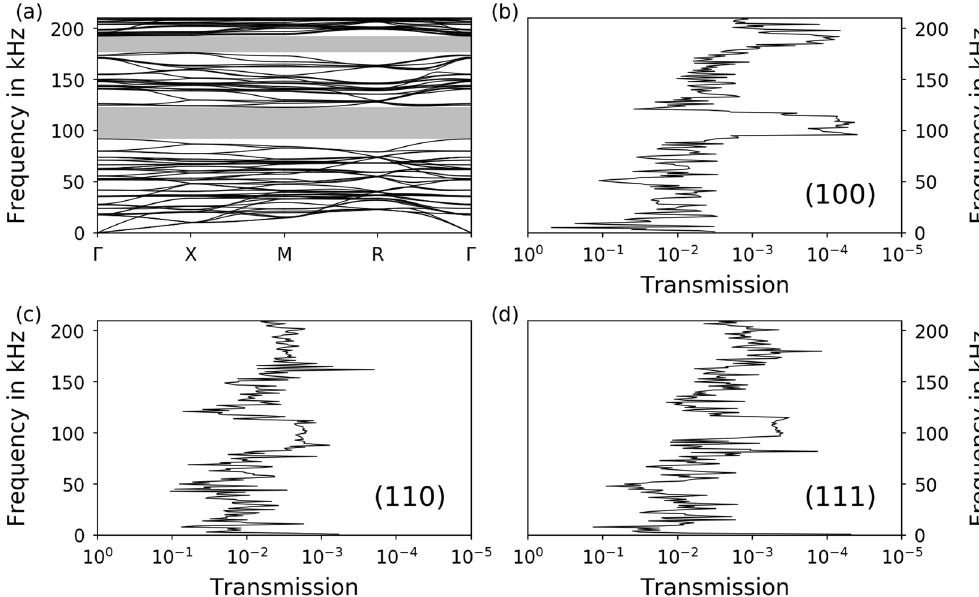
Figure 3. Comparison of numerical dispersion relation and experimental transmission results along different crystallographic directions (samples with l = 5.0 mm and A = 1.0 mm). ( a ) Numerical dispersion relation (d = 0.52 mm) with complete band gaps indicated in grey. ( b ) Experimental transmission spectrum of a sample with transmission direction (100), ( c ) (110) and ( d ) (111) with a thickness of 0.52 mm 0.08